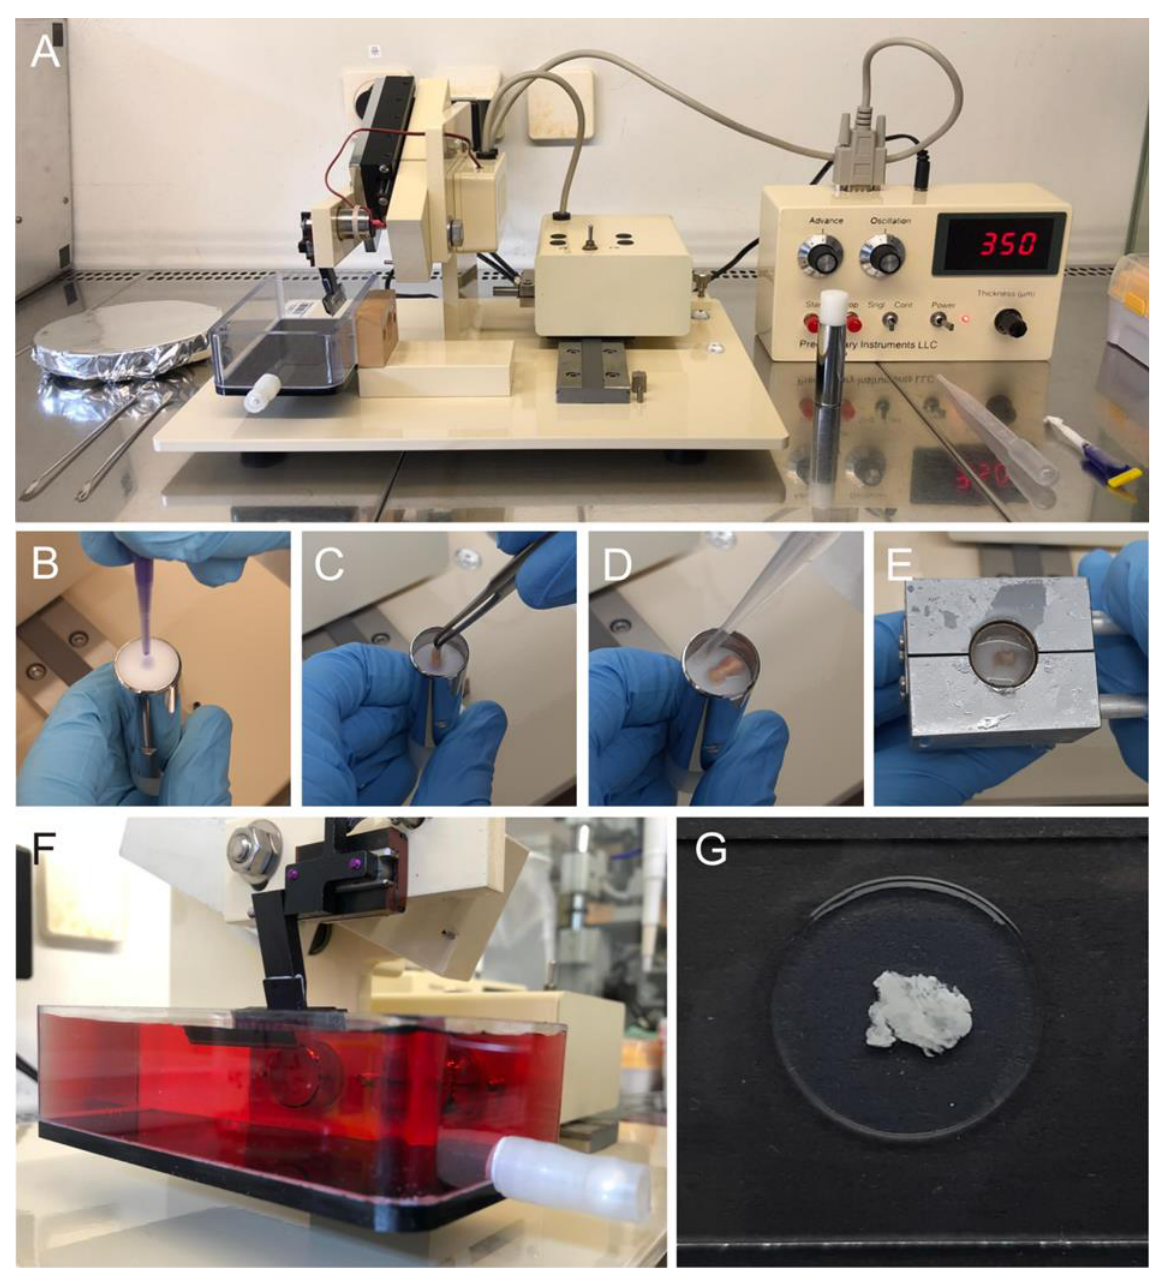
Figure 2. Preparation of organotypic hippocampal brain slice cultures (OHSC) and patient-derived tumor slices. ( A ) Vibratome and instruments required for the generation of tissue slices. ( B ) Histoacryl glue was placed onto the vibratome’s sample tube. ( C ) The brain and tumor, respectively, were glued on edge into the tube and ( D ) filled with molten agarose. ( E ) The agarose was hardened with a cooling block pre-cooled at −8 0 °C. ( F ) The vibratome was used to generate slices of 350 µm thickness. ( G ) The tumor slices were encased in agarose.